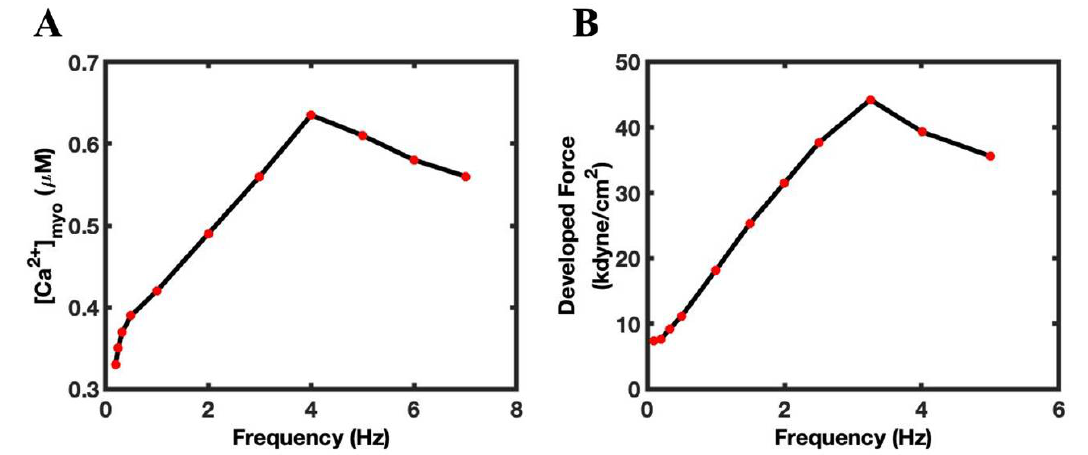
Figure 3. The Ca 2+ transient FFR curve. ( A ) derived from the model with simulation from 0.2 to 7 Hz, with primary positive FFR (0.2–4 Hz) and secondary phase negative FFR (5–7 Hz). ( B ) An experimental FFR of guinea pig cardiac papillary muscles showed positive FFR (1–3.5 Hz) (data from [40] ).